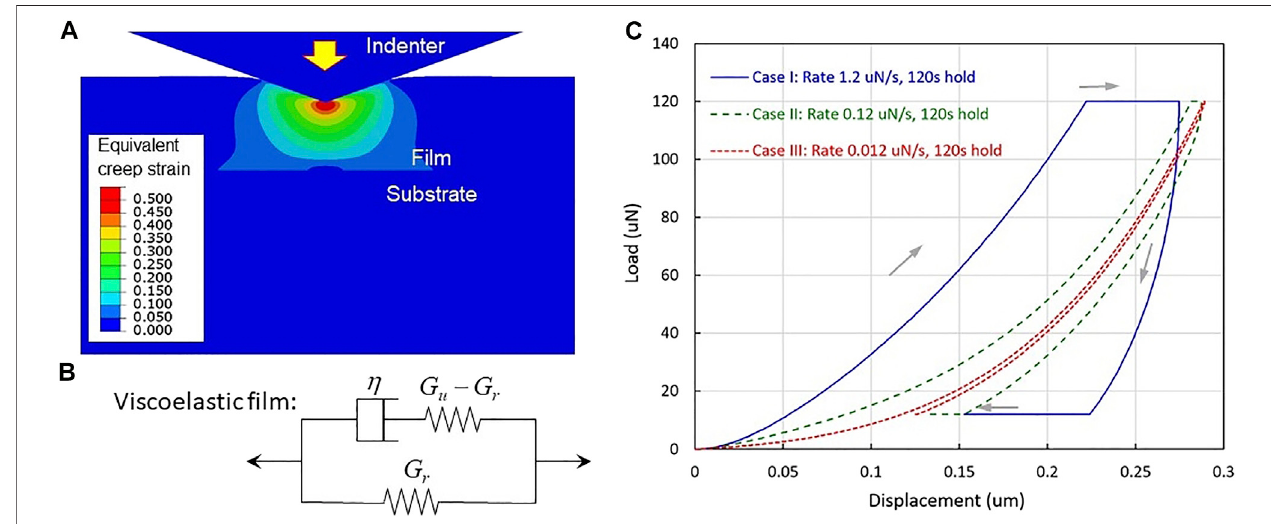
FIGURE1|(A) Modelcon fi gurationneartheindentationsite,andthecontoursofequivalentcreepstrainintheviscoelasticthin fi lmduringindentation (B) Thethree- element standard linear solid model used for the viscoelastic fi lm (C) Simulated indentation load-displacement curves for Cases I, II and III. The fi nite element software ABAQUS (Version 2017; Dassault Systems Simulia Corp., Johnston, RI, United States) was used for the modeling.